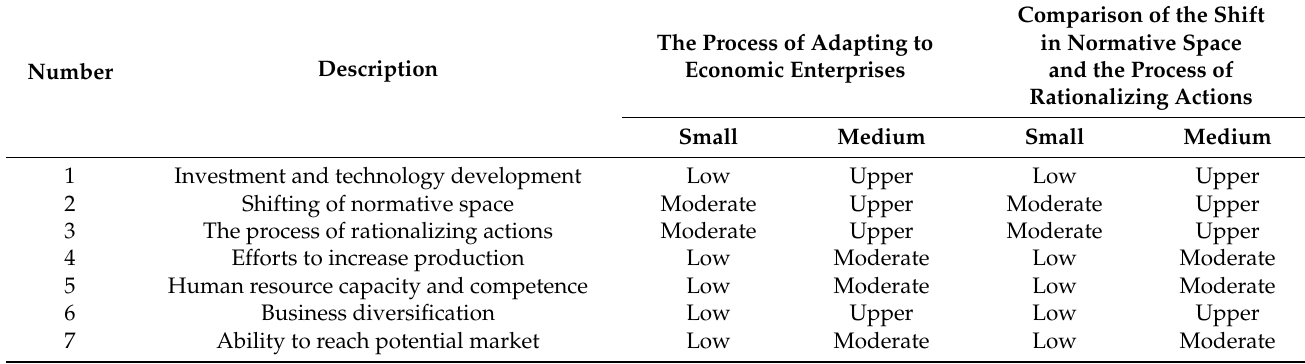
Table 5. A comparison of the processes of business adaptation, shifting normative spaces, and rationalizing actions.